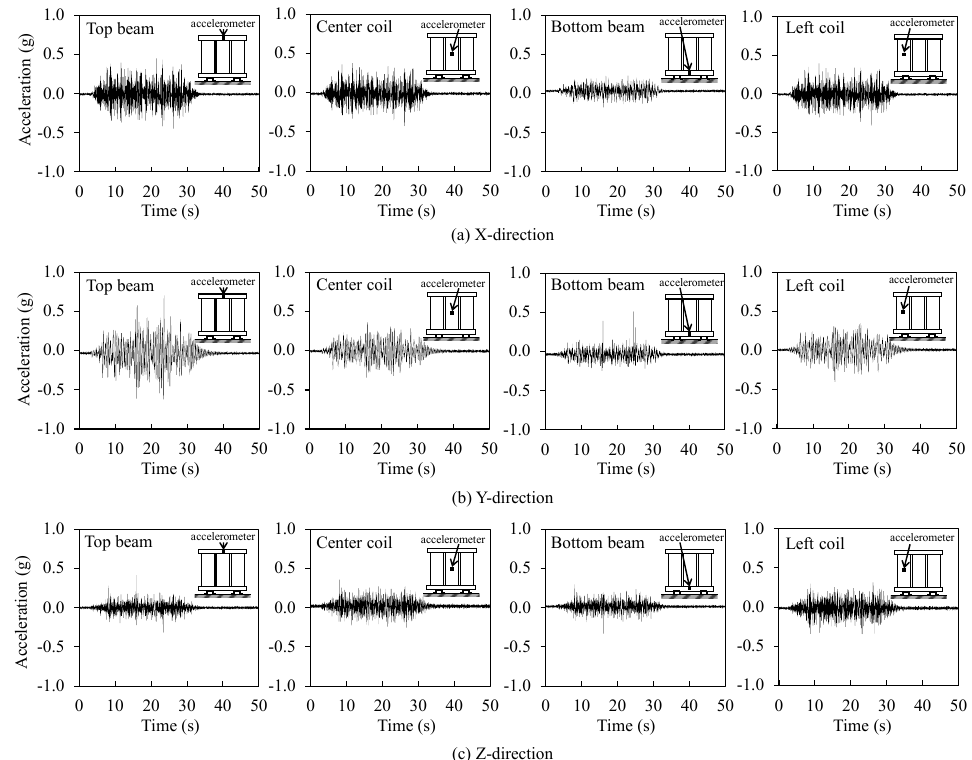
Figure 12. Acceleration response-time histories of test specimen of AC156_75.